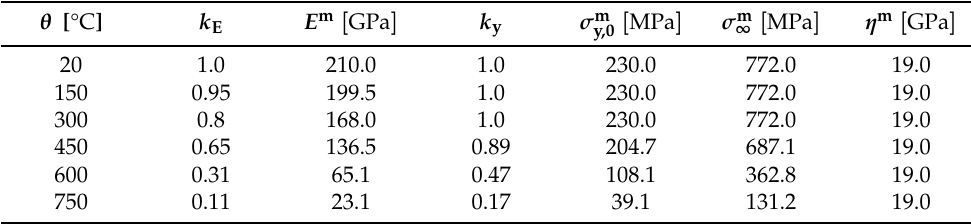
Table 2. Temperature-dependent mechanical material parameters of the pearlitic matrix. Temperature θ ; reduction factor of the Young’s modulus, k E ; Young’s modulus E m ; reduction factor of the yield strength, k y ; yield strength σ m ; saturation stress σ m ∞ ; saturation rate η m . y,0 θ [ °C ] k E E m [ GPa ] k y